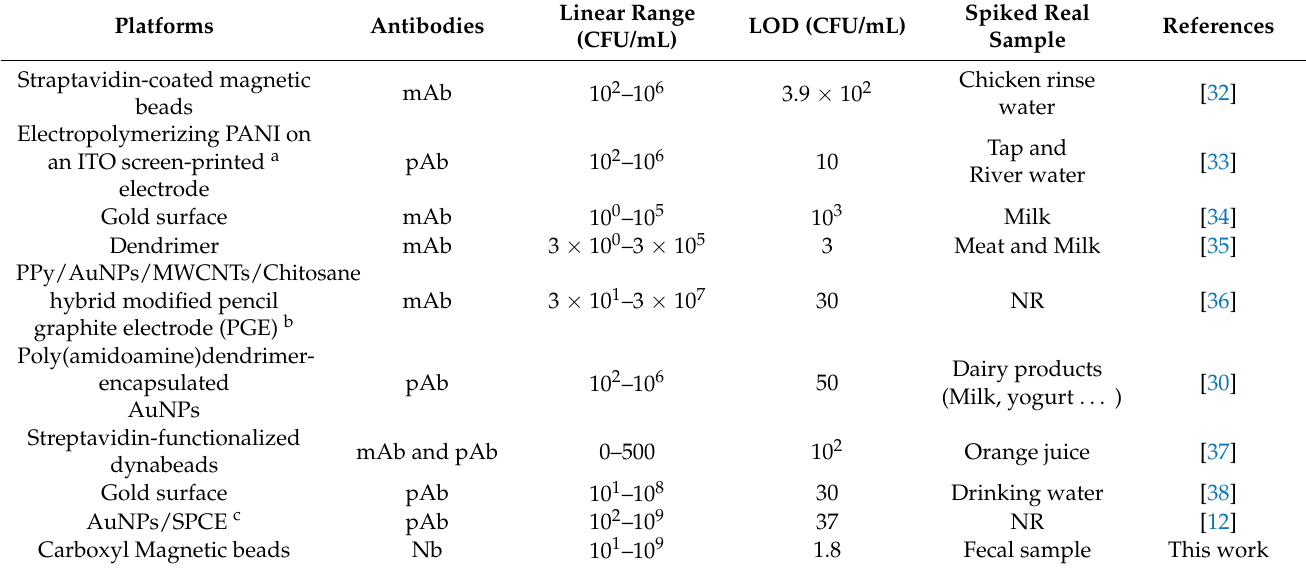
Table 1. Performances of reported immunoplatforms for the detection of E. coli